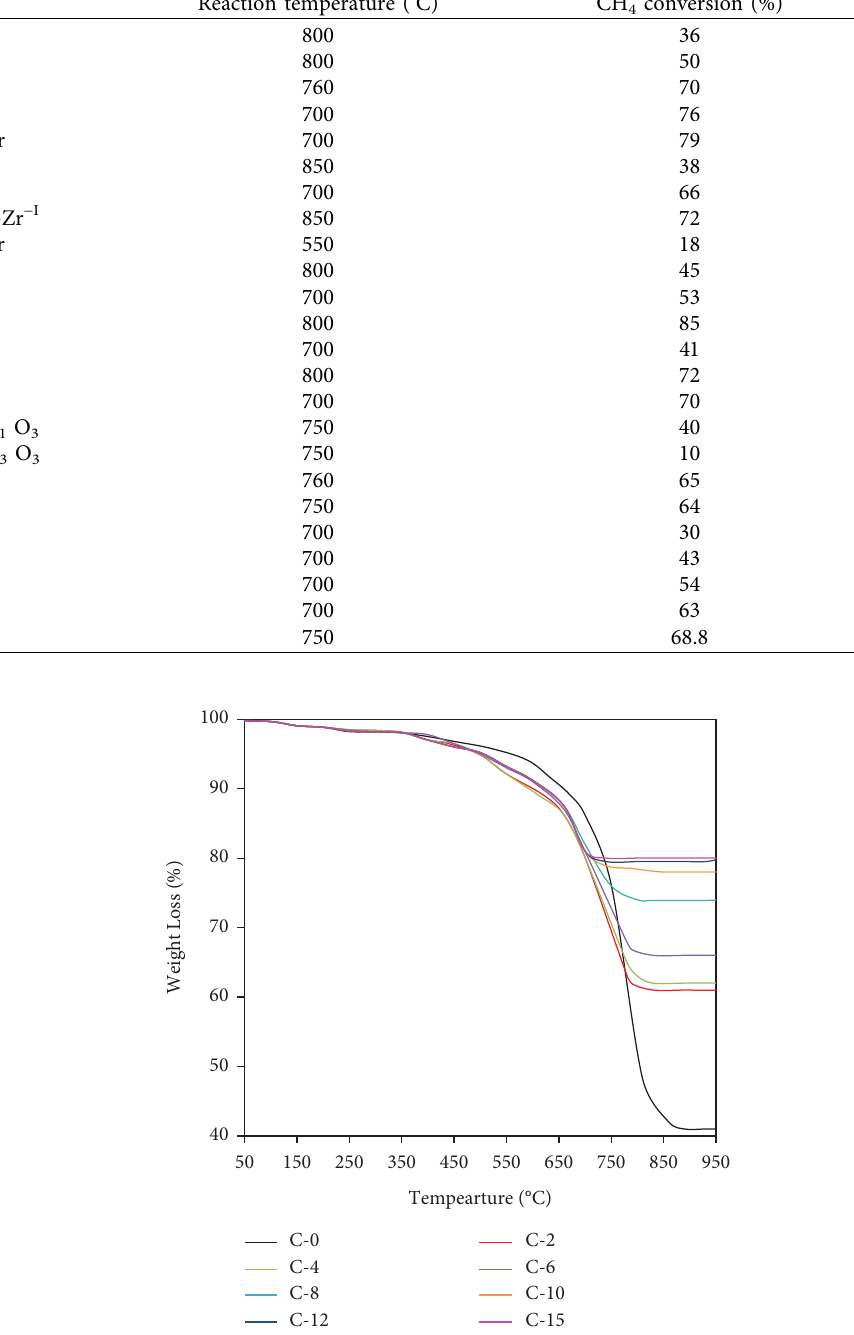
Figure 9: TGA profle of all spent catalysts.